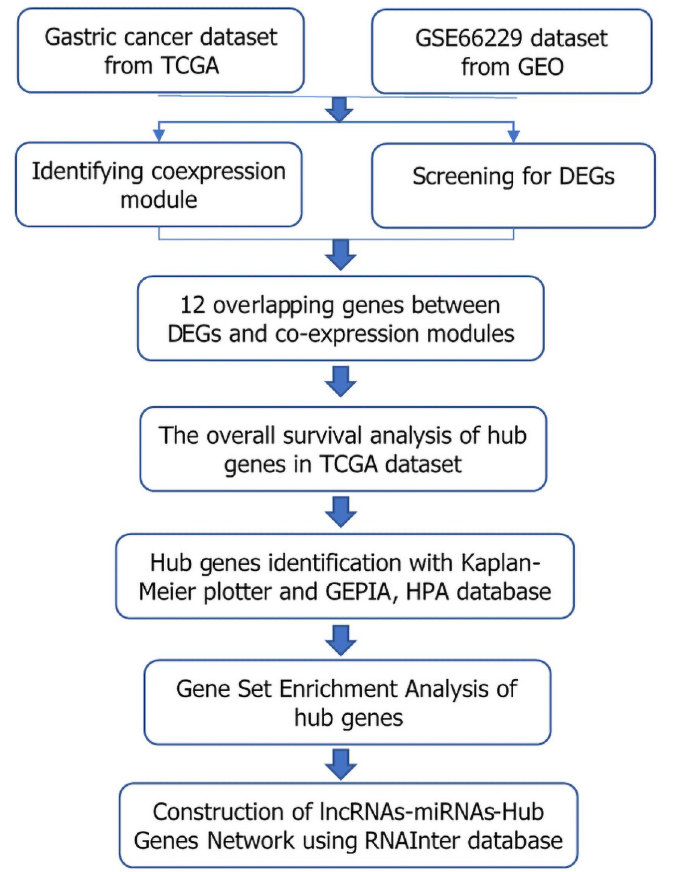
Fig 1. Study design and workflow of this